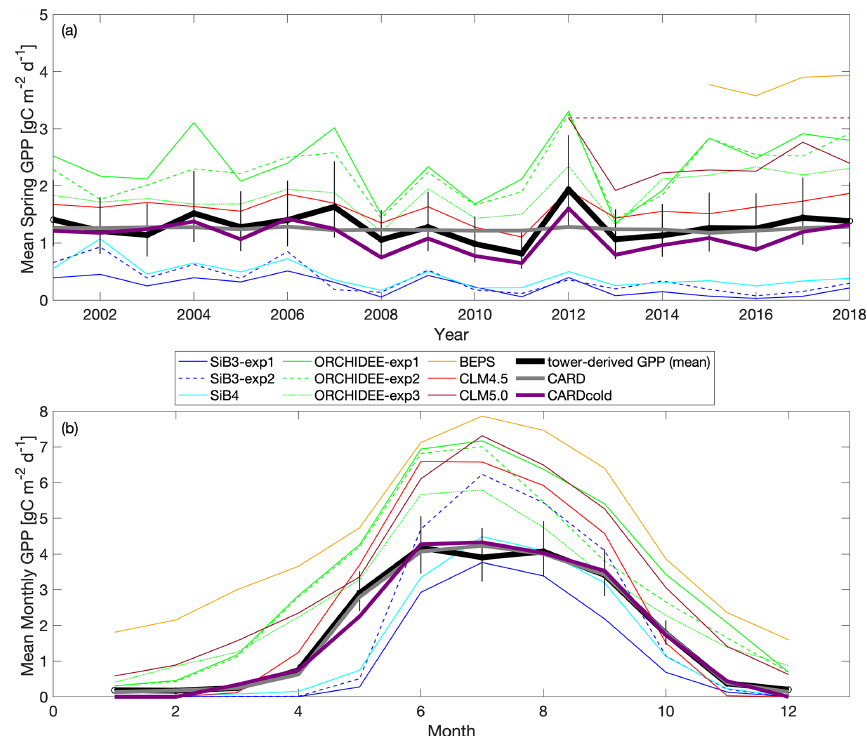
Figure 7. Comparison of TBM-MIP models to CARD and CARDcold experiments for (a) mean spring GPP for 2000–2018 and (b) monthly GPP from 2015–2018. Note that fill values are ignored when calculating mean annual values for TBM-MIP experiments. Uncertainty is (cid:112) ( log ( 2 ) 2 · n)/n) , where n is the number of years on average ( n = 19). exp (